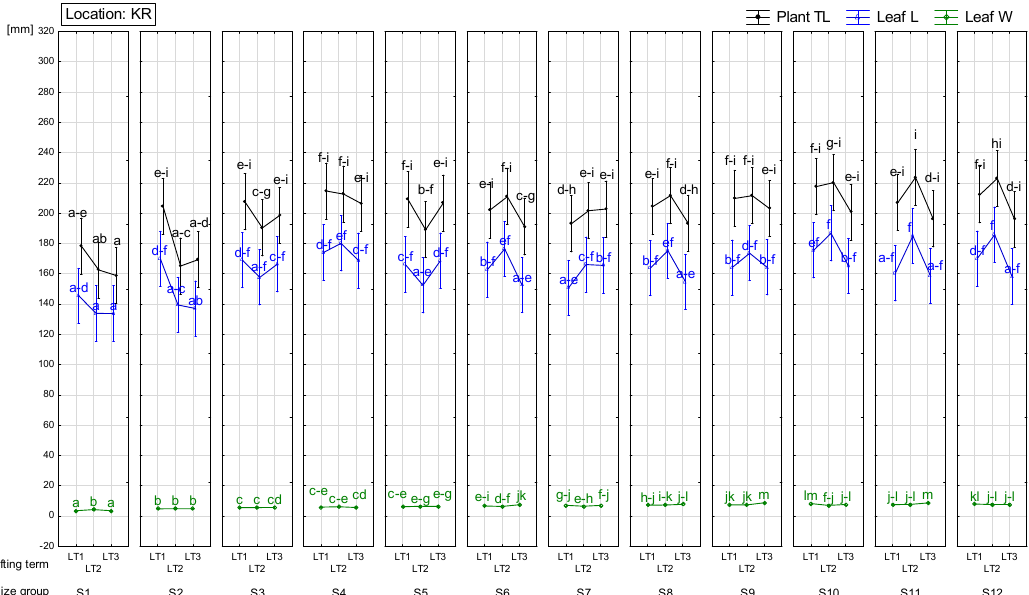
Figure 7. Effect of size group and lifting term on morphological features of bulbs and leaf for Krakow (KR) location. Mean values within the same color with different letter are significantly different according to Duncan’s multiple range test at p ≤ 0.05. For treatments description, see Sections 2.1–2.4, Materials and Methods sections.